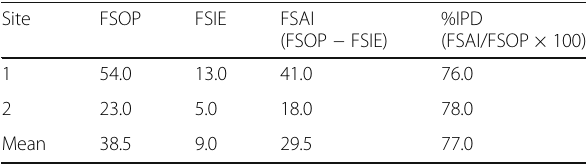
Table 1 Insect pollinator dependency of shea fruit set in